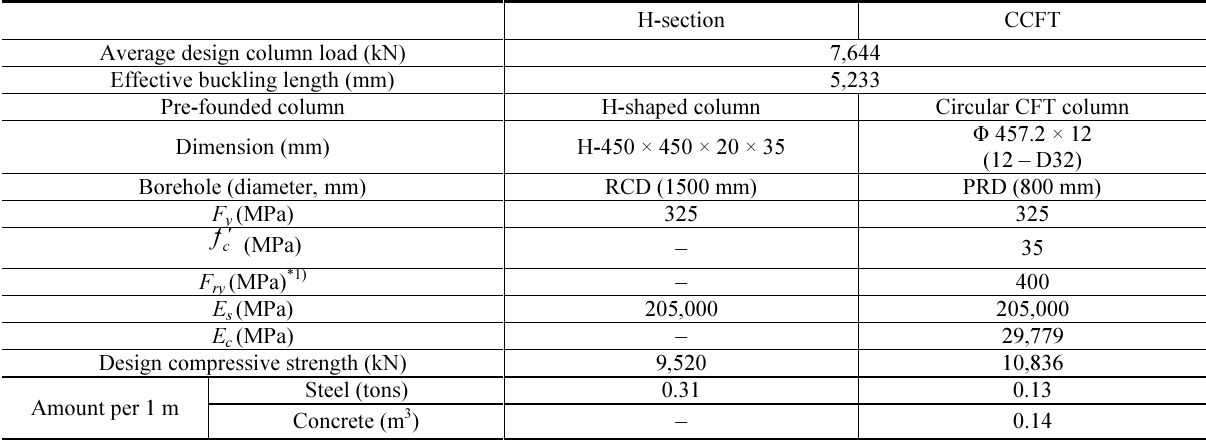
Table 4. Comparison of the H-shaped column and circular CFT column used in the seventh basement